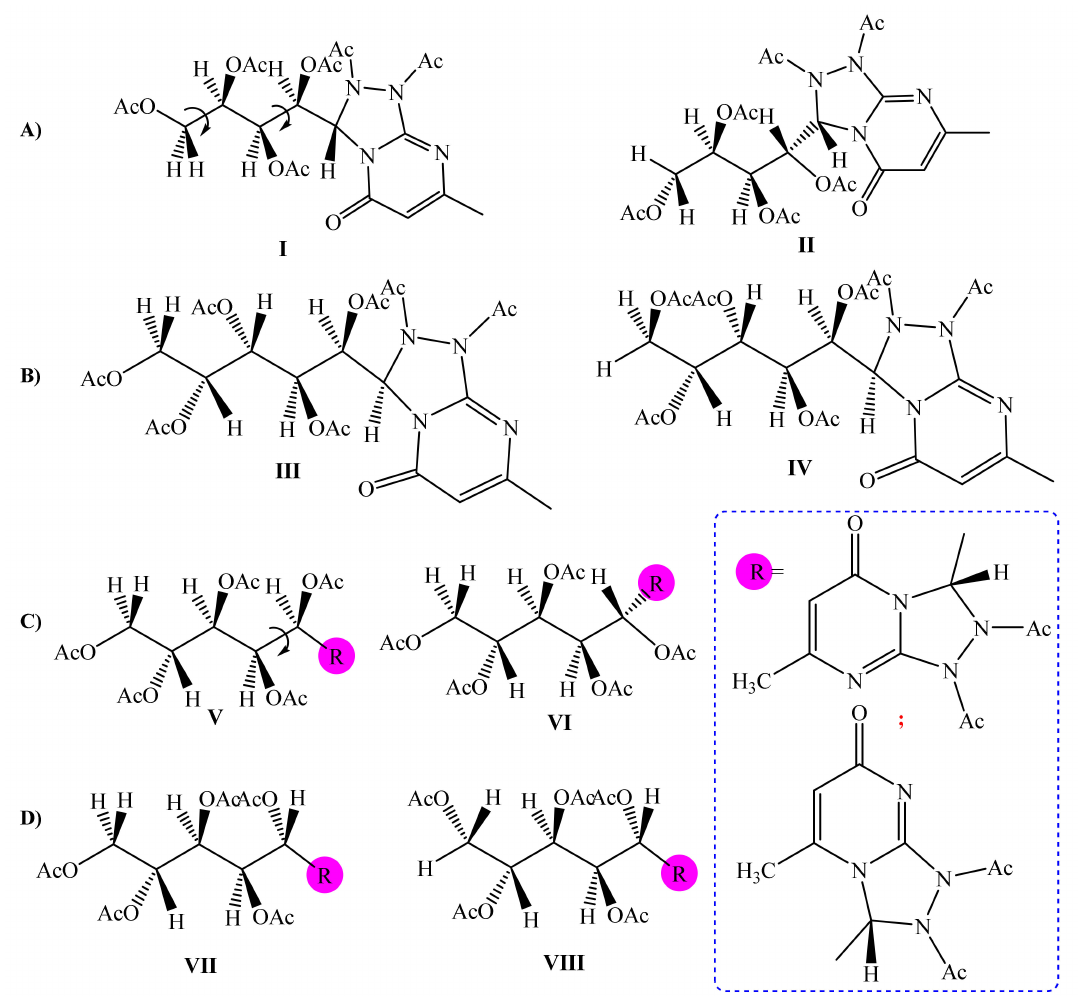
Figure 2. ( A ) Zigzag conformation of 6 , ( B ) zigzag conformation of 7 , ( C ) zigzag conformation of 8, and ( D ) zigzag conformation of 9